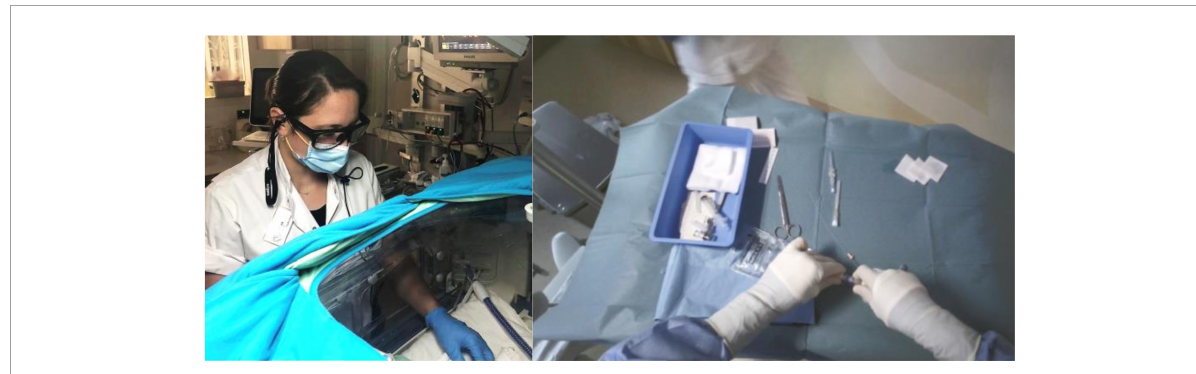
FIGURE3 Use of the Tobii eye-tracking glasses on the Neonatal Intensive Care Unit (NICU)of the Leiden University Medical Center (LUMC), which give a unique point-of-view recording.